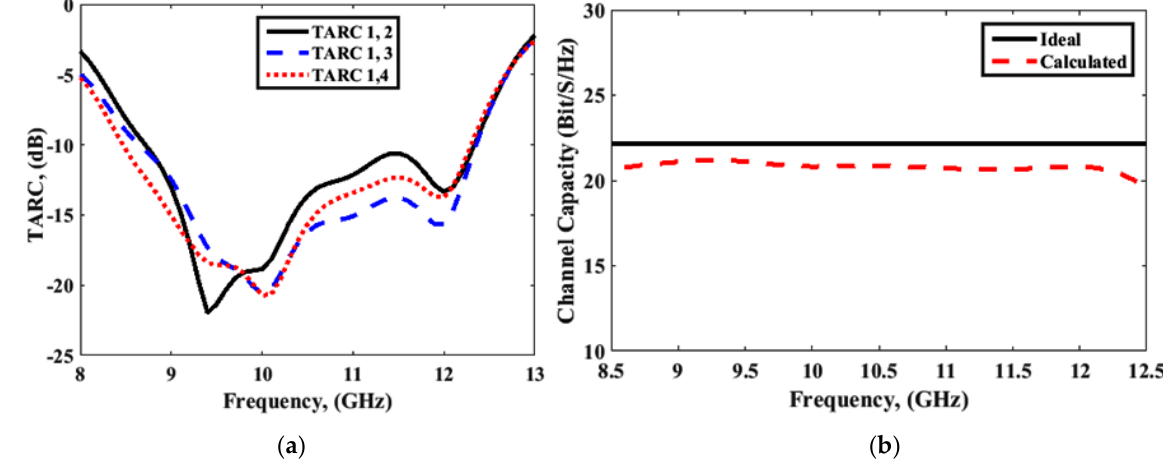
Figure 21. ( a ) Total active reflection coefficient (TARC); ( b ) channel capacity. Table 2. Comparison with other CP MIMO DRAs.